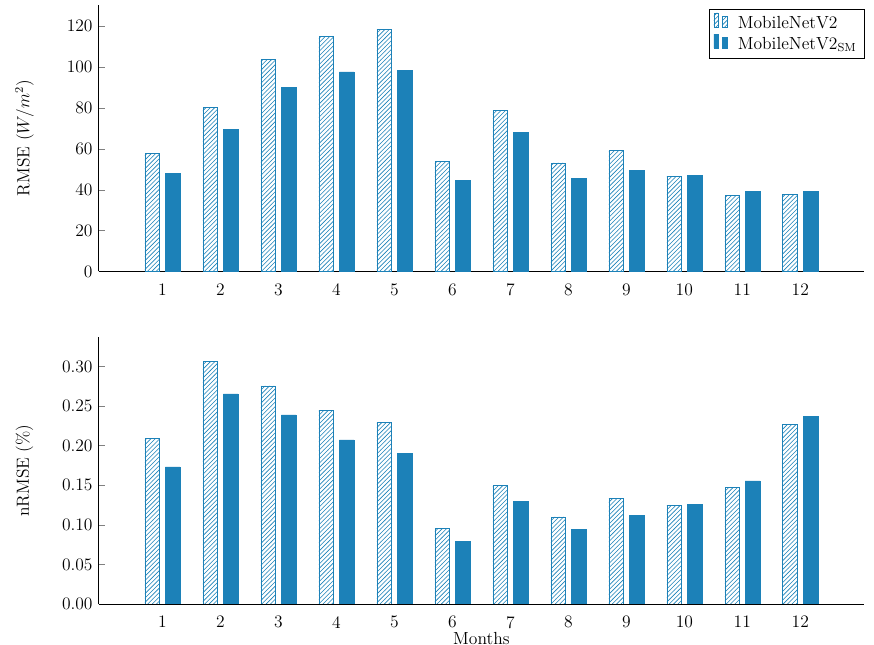
Figure 9. RMSE and nRMSE monthly plots for MobileNetV2 with and without the